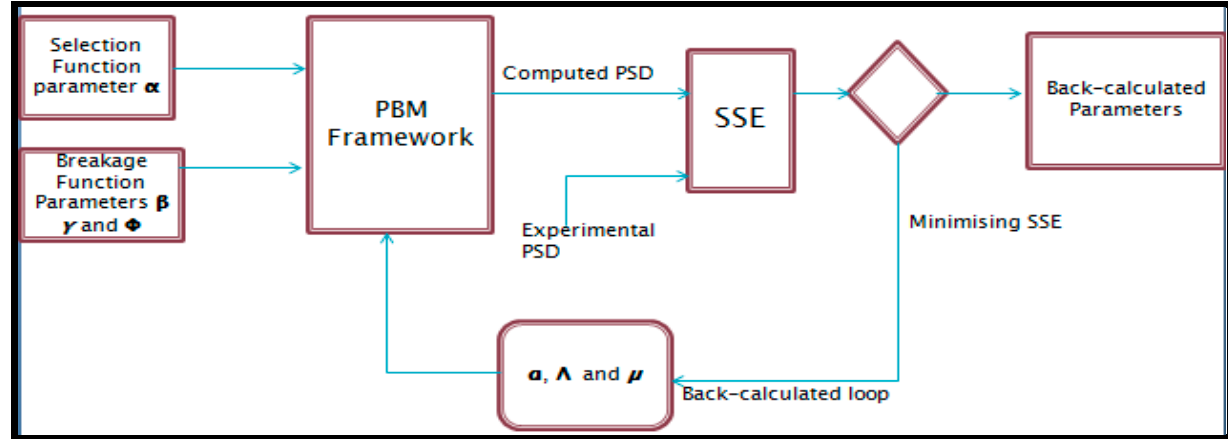
Figure 2. Diagrammatic representation of the back-calculation procedure adapted from [20].